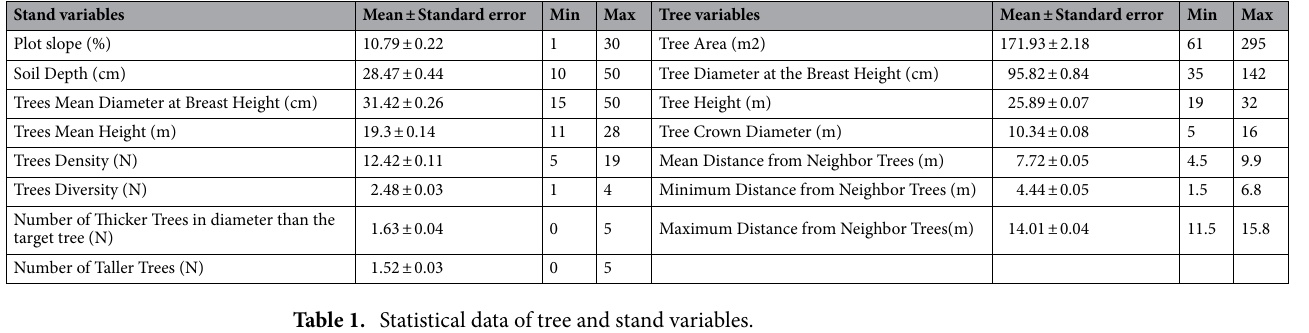
Table 1. Statistical data of tree and stand variables.